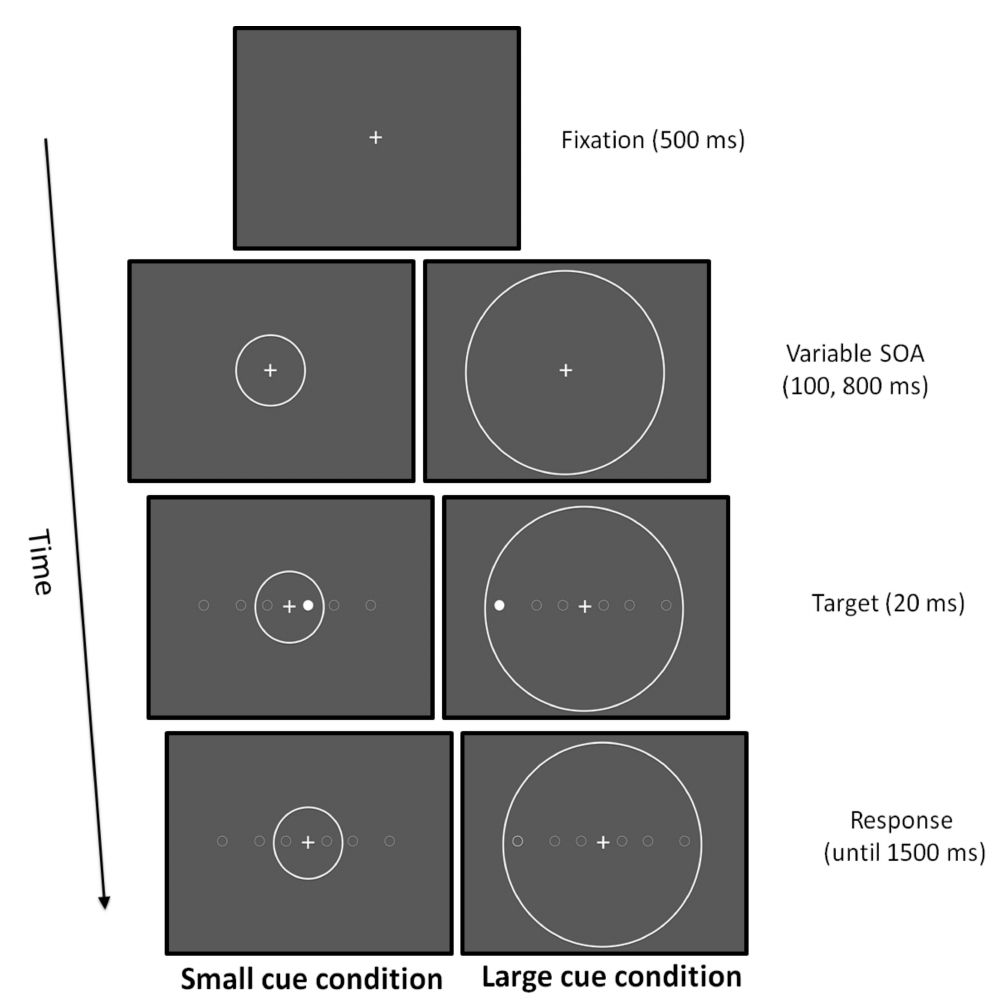
Figure 2. Attentional zooming